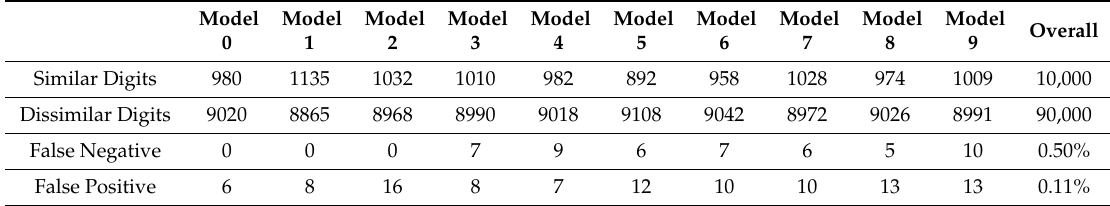
Table 1. Individual model experimental